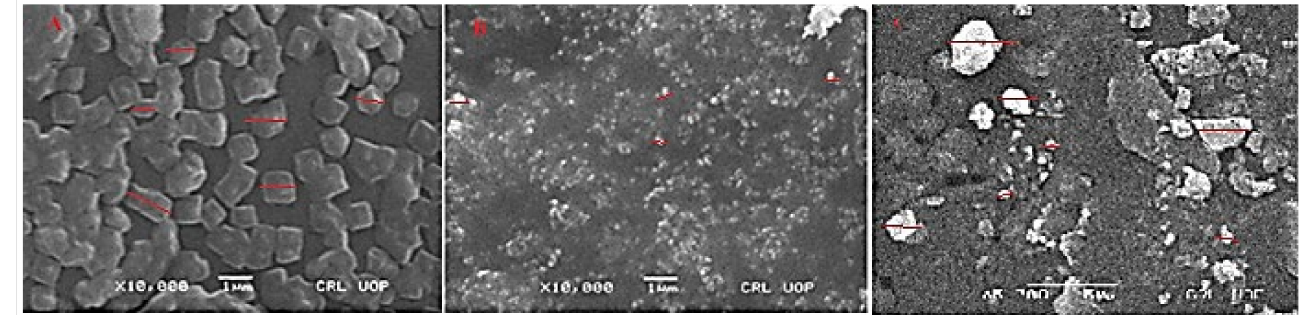
Figure 8. SEM images of Indigofera linifolia Ext+PEG NPs ( A ), Ext+Ch NPs ( B ), and Ext+LGB NPs ( C ).